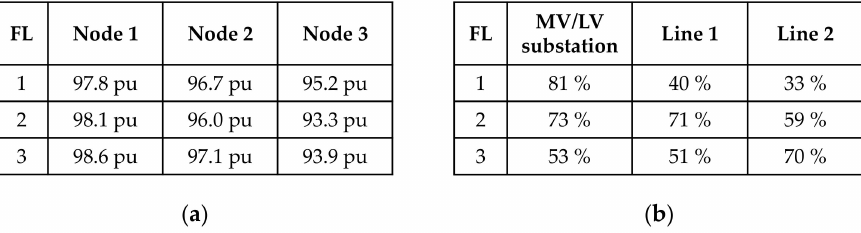
Figure 6. Exemplary output of static load flow simulations performed for three feeder levels (FL): Each node’s voltage ( a ) and the thermal utilization of the MV/LV substation and lines ( b